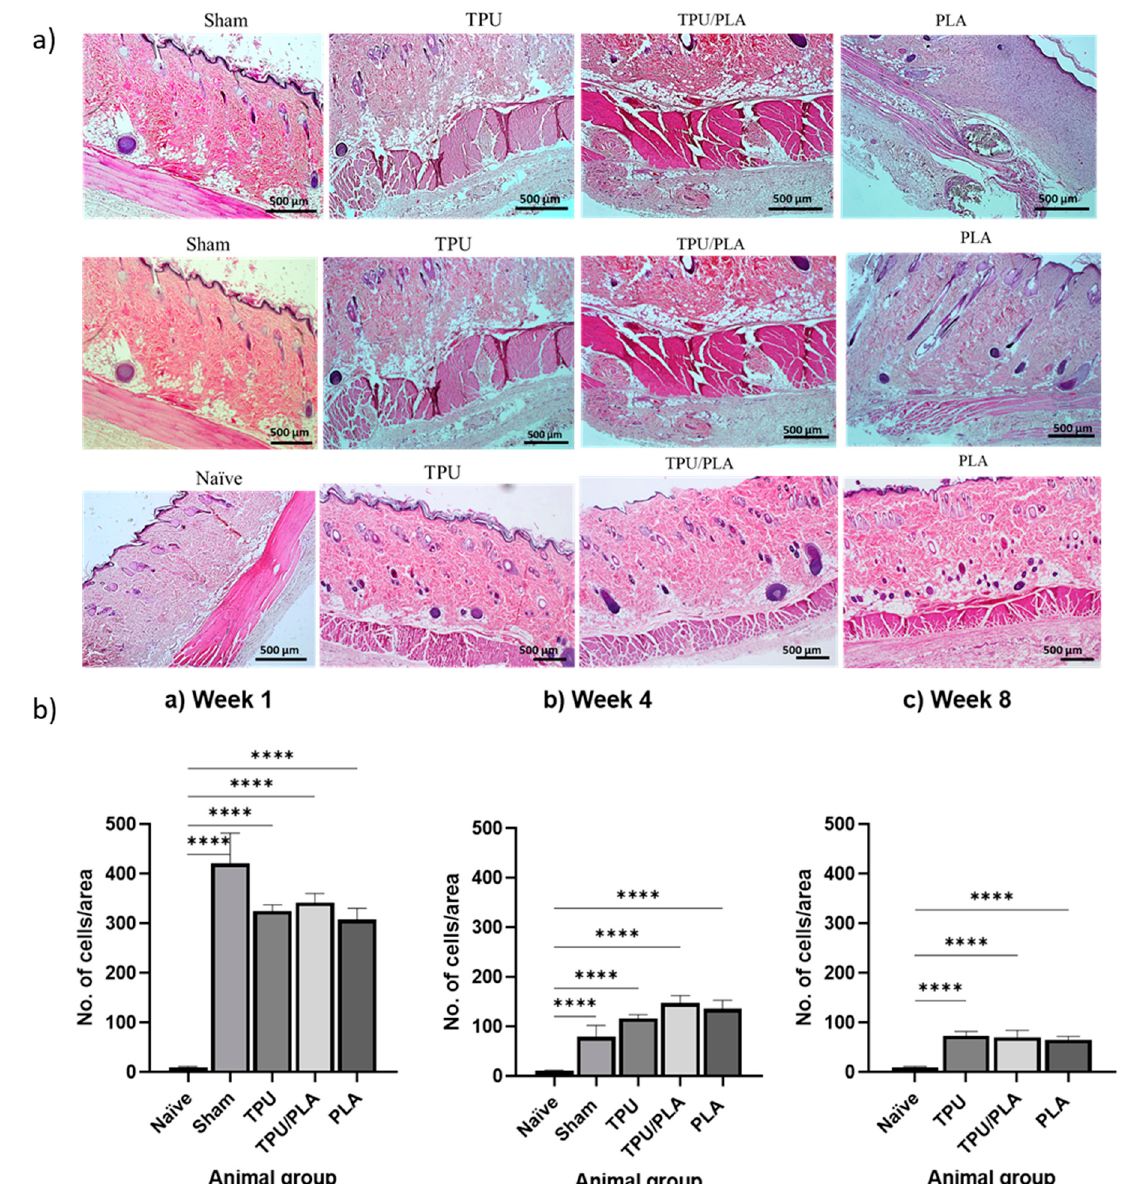
Figure 7. ( a ) Photomicrograph of tissue adjacent to the implanted scaffold showing inflammatory reaction in rat skin. Histological sections of a representative subcutaneous area were stained with H&E at 4× magnification. ( b ) Semi-quantitative scoring of the number of inflammatory cells in rats. The number of inflammatory cells at (a) week 1, (b) week 4, and (c) week 8. The X -axis represents the animal groups, while the Y -axis indicates the number of inflammatory cells. At week 1, inflammatory responses were significantly different and highest in all experimental groups compared to the naïve group, significantly reduced at week 4, and gradually decreased at week 8, with mild inflammation present. One-way ANOVA with Tukey’s multiple comparison test was used for comparison between groups. Data are presented as mean ± SD, n = 2 animals per group, **** p < 0.0001.